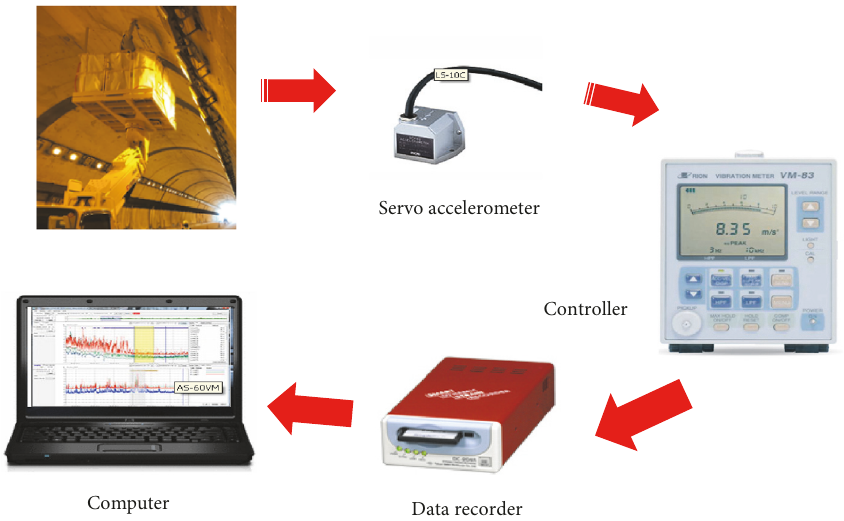
Figure 6: The microtremor measurement system of tunnel